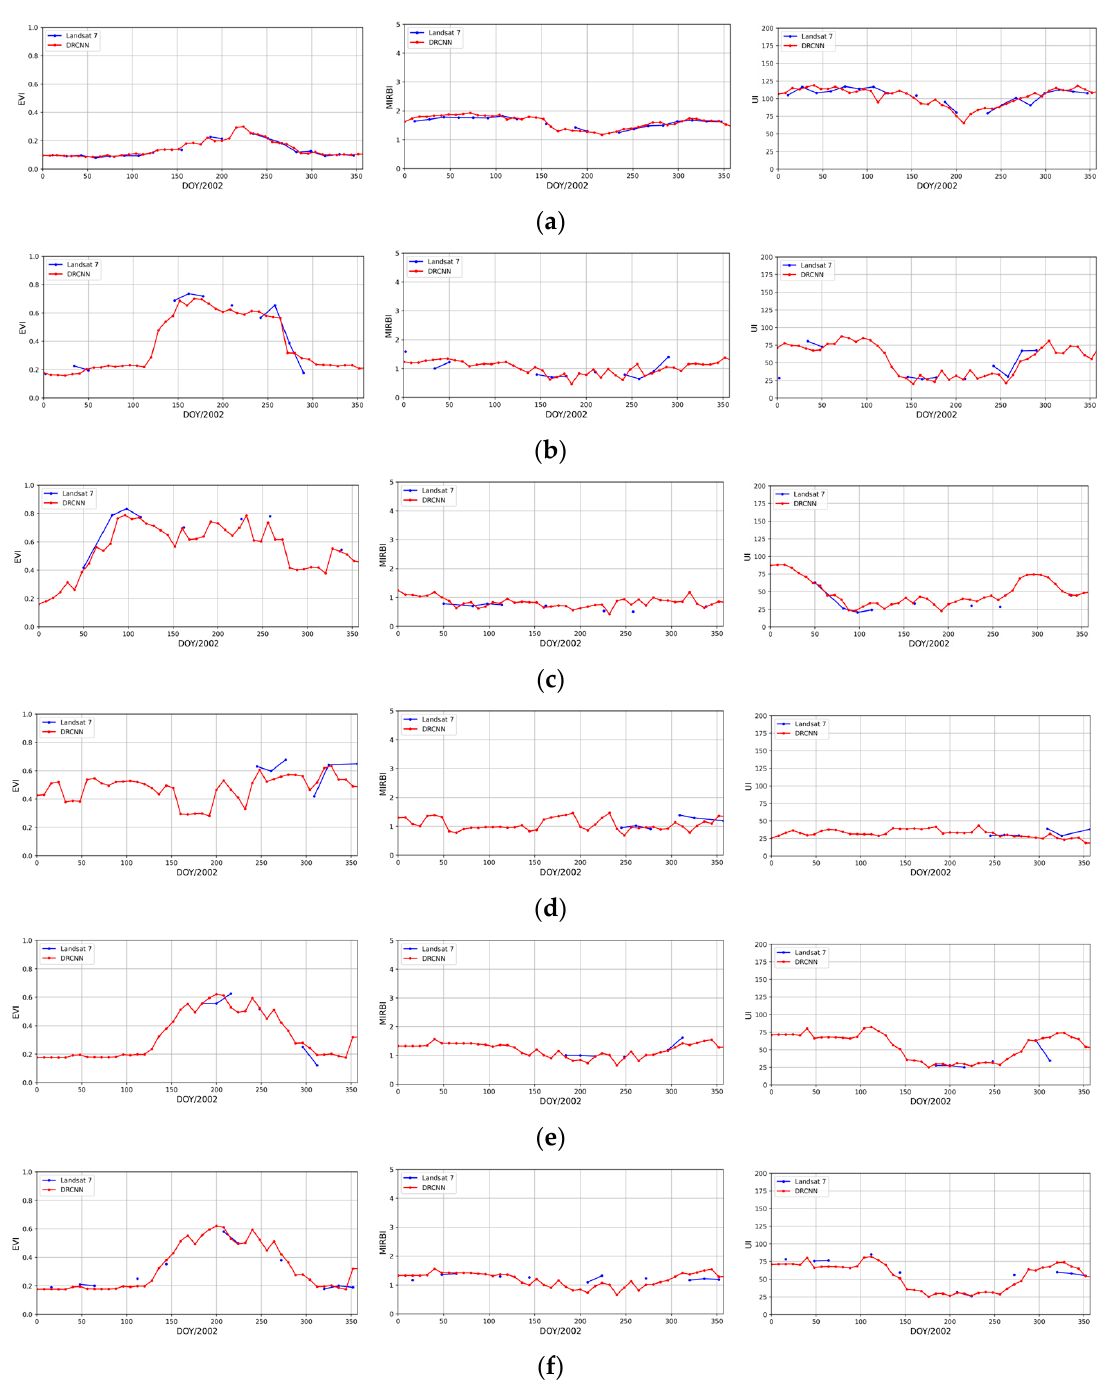
Figure 12. Time series of EVI, MIRBI and UI calculated from the downscaled surface reflectance from the DRCNN and the surface reflectance from Landsat 7 at the ( a ) Zhangbei, ( b ) Collelongo, ( c ) Barrax, ( d ) Counami, ( e ) Larose and ( f ) Camerons sites in 2002.